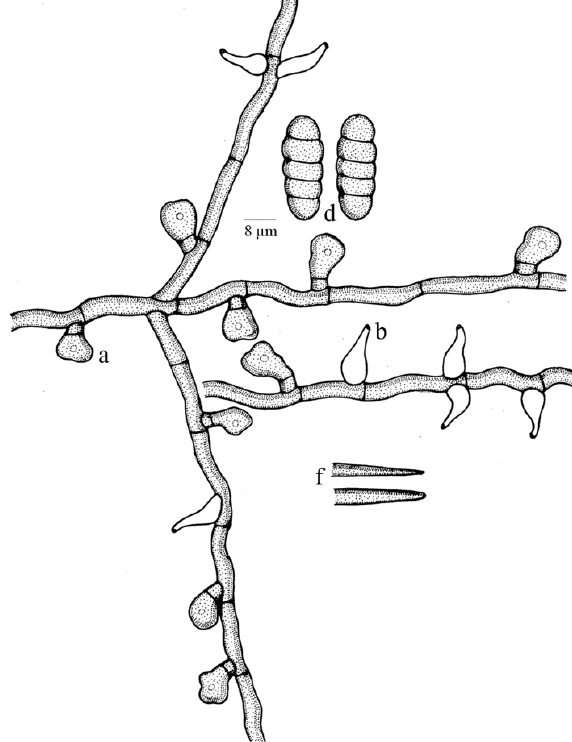
Figure 29. Irenopsis sidae var. indica a - Appressorium; b - Phialide; f - Apical portion of the perithecial; d -